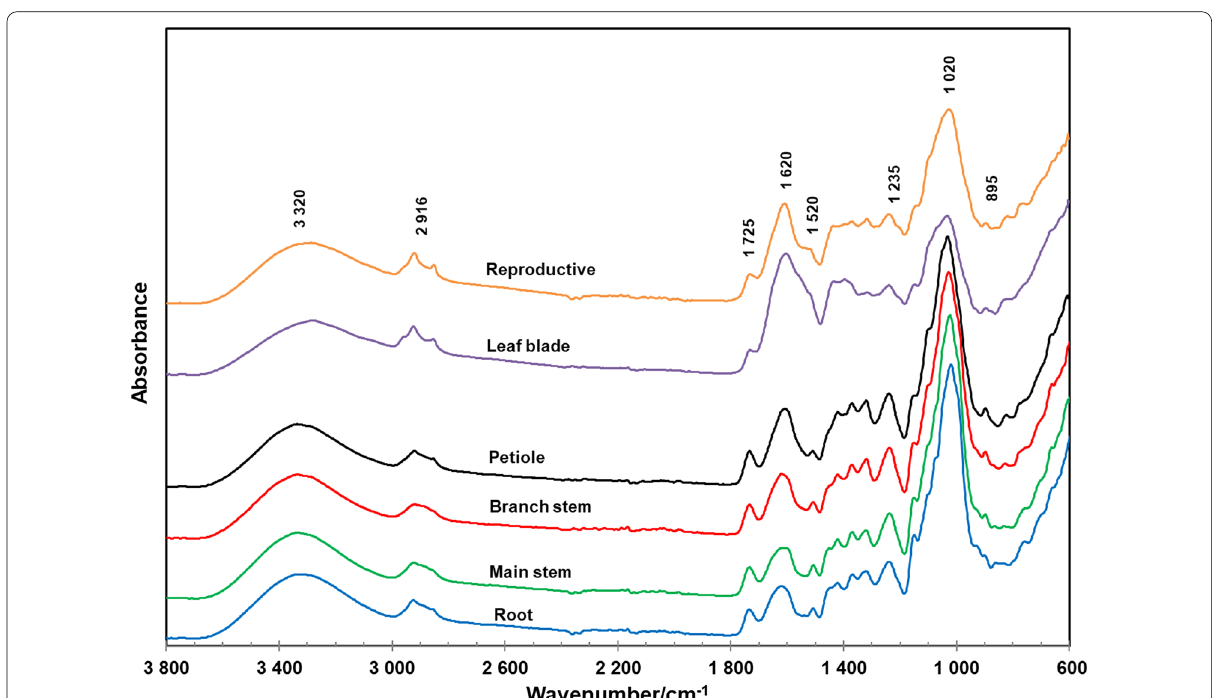
Fig. 4 ATR FT-IR spectra of six different cotton organs and tissues collected from cotton plants at the reproductive